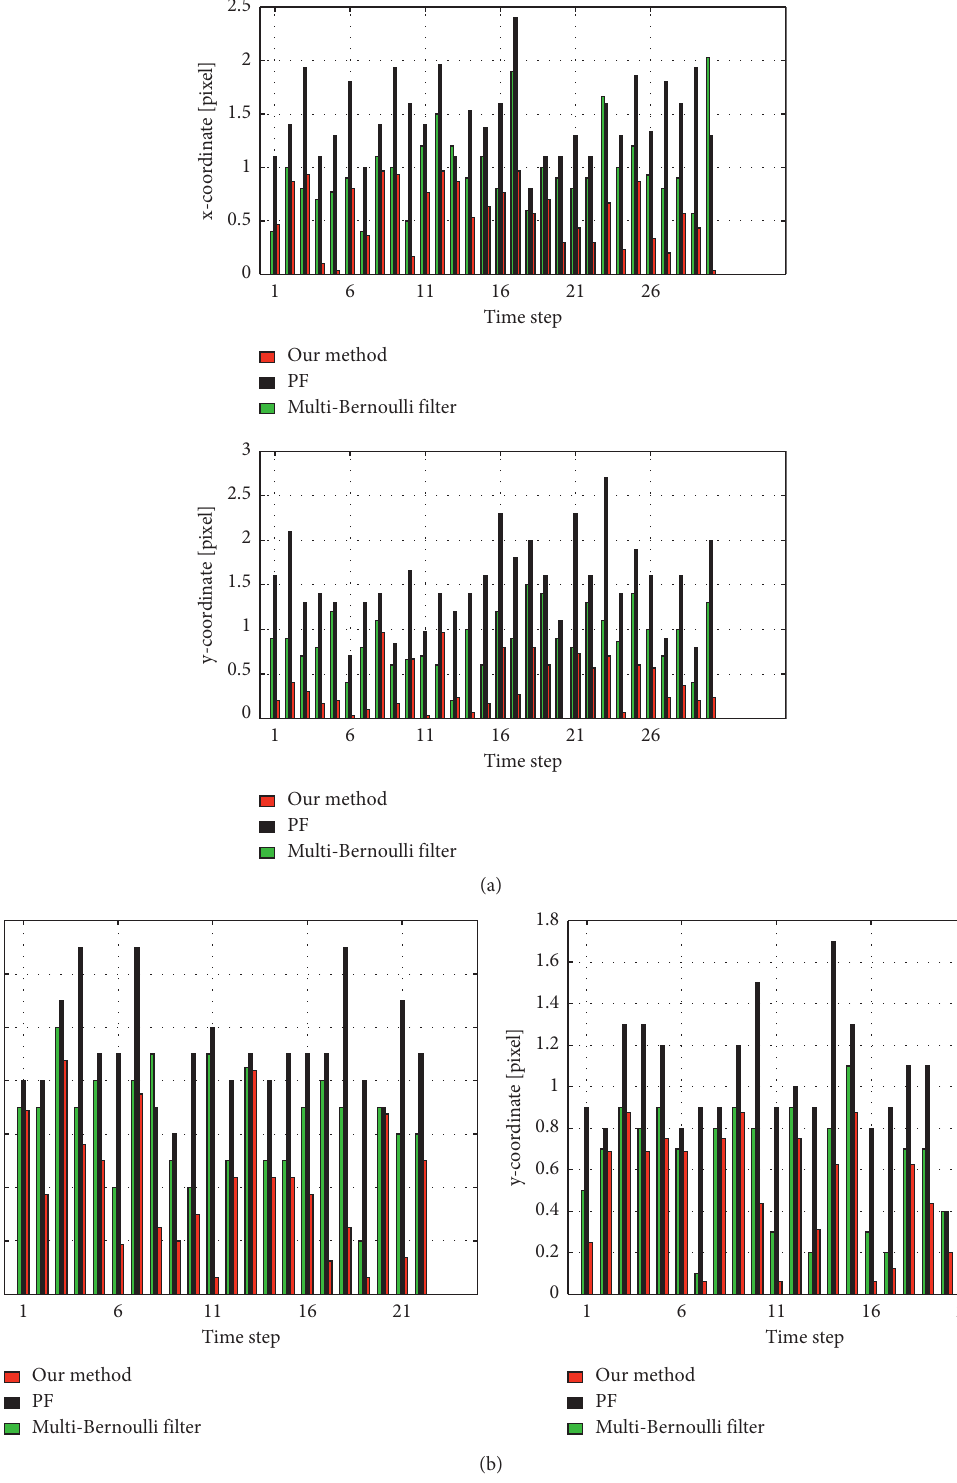
Figure 11: The RMSE comparisons using various methods. (a) Cell image in sequence 1. (b) Cell image in sequence